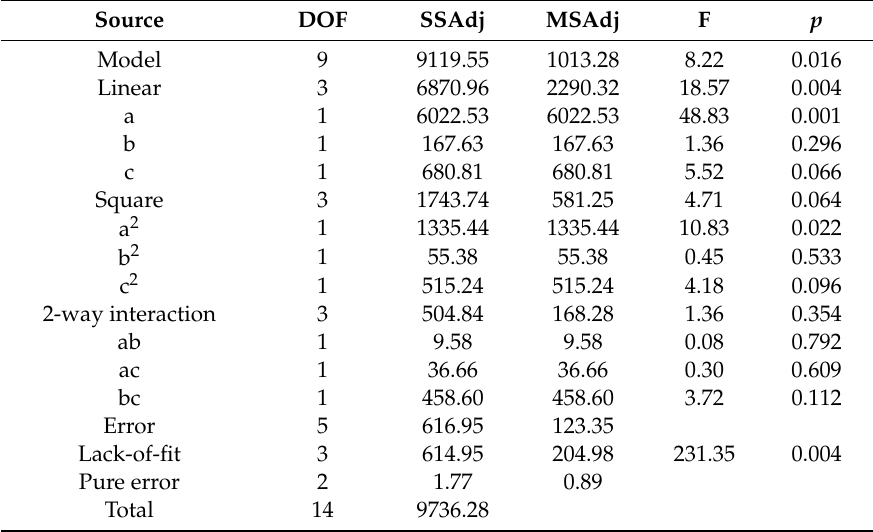
Table 7. Analysis of variance of quadratic polynomial regression model of Box-Behnken